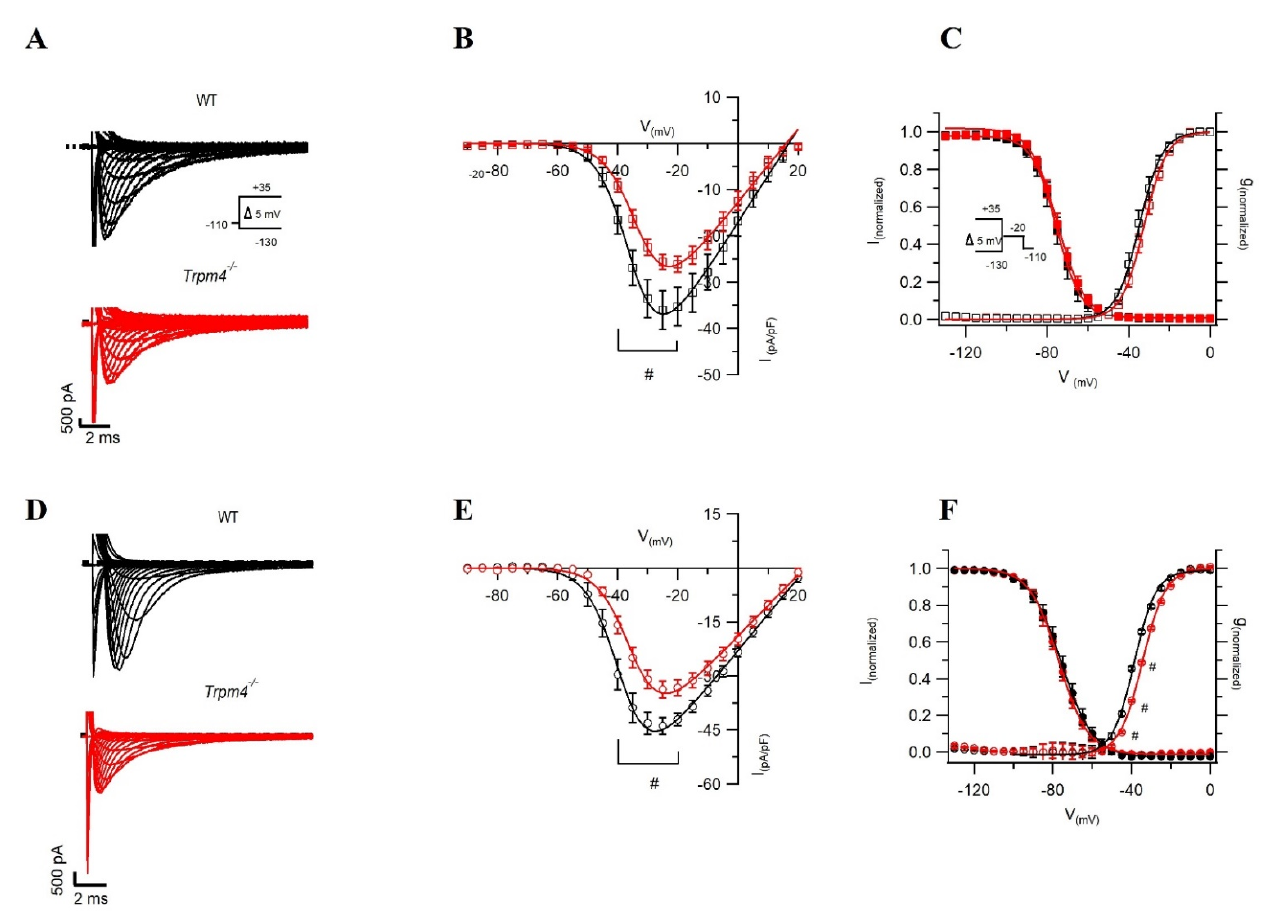
Figure 3. Na + current recordings from isolated cardiomyocytes. Representative Na + current traces recorded from myocytes in WT (black) or Trpm4 − / − (red) mice, either from ventricular ( N = 5, n = 9 WT, n = 12 Trpm4 − / − ) ( A ) or atrial ( N = 5, n = 20 WT, n = 22 Trpm4 − / − ) tissue ( D ), using a voltage step protocol as shown in inset. Na + current–voltage relationships in WT and Trpm4 − / − mice from either ventricular ( B ) or atrial ( E ) cardiomyocytes. ( C , F ) Voltage dependence of activation (open square or circle) and inactivation (filled in square or circle) fitted with Boltzmann equation in WT and Trpm4 − / − mice from either ventricular or atrial cardiomyocytes, respectively. Note: #: p < 0.05, WT vs. Trpm4 − / − at a given voltage). Table 2. Summary of I Na patch clamp data. (#: p ≤ 0.05, WT vs. Trpm4 − / − ).